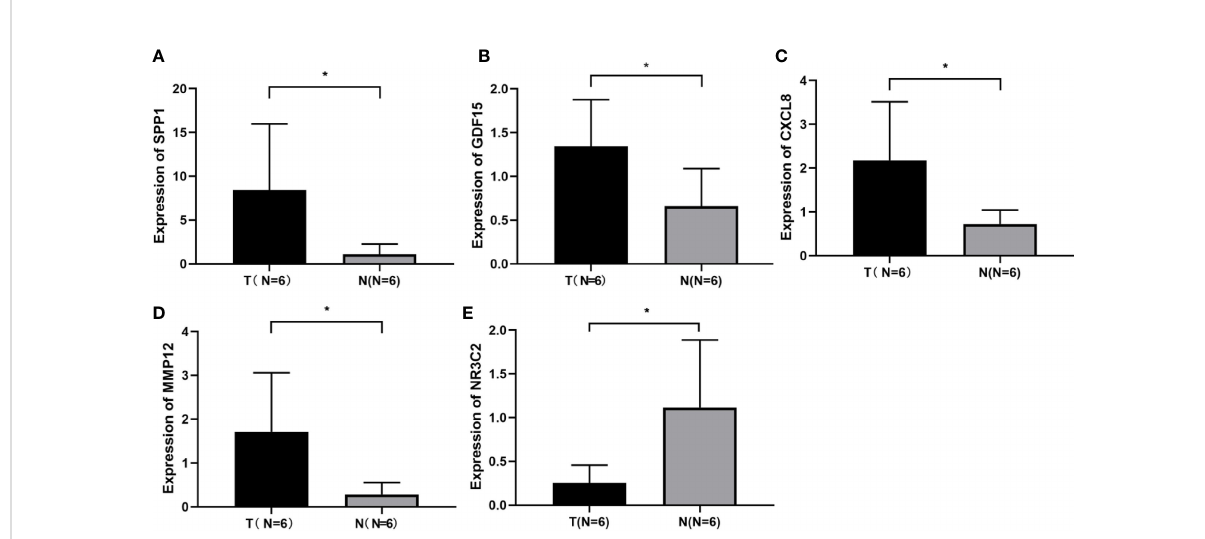
FIGURE 3 Identi fi cation of screened DEGs (A) The expression of gene of SSP1 in the indicated groups. (B) The expression of gene of GDF15 in the indicated groups. (C) The expression of gene of CXCL8 in the indicated groups. (D) The expression of gene of MMP12 in the indicated groups. (E) The expression of gene of NR3C2 in the indicated groups. *p<